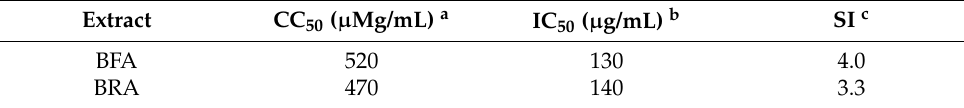
Figure 3. BFA and BRA extracts exert a dose–response antiviral activity against ZIKV. ( A ) A549 cells were incubated with B. gymnorhiza extracts (400 to 12.5 µ g/mL) for 72 h. Cell viability was assessed by MTT assay. Results are given as means ± SD of four independent experiments and expressed as relative values compared to vehicle. ( B ) A549 cells were infected with ZIKV GFP at MOI of 2 in presence of B. gymnorhiza extracts (400 to 12.5 µ g/mL). After 24 h of infection, flow cytometric analysis of GFP fluorescence was conducted. The results are given as means ± SD of four independent experiments and expressed as relative value in contrast to untreated infected cells. Table 4. Cytotoxicity and anti-ZIKV activity of B. gymnorhiza